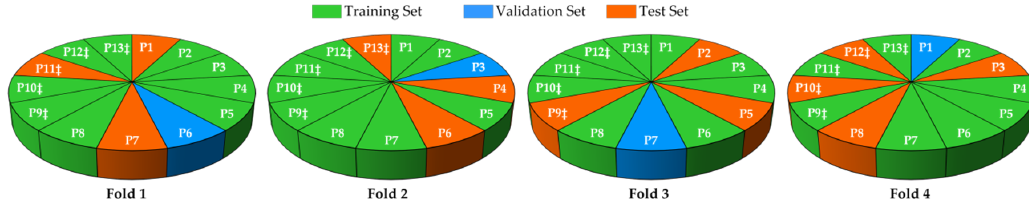
Figure 3. Data partition among the different folds (patients with only tumor samples are marked with ‡ ).